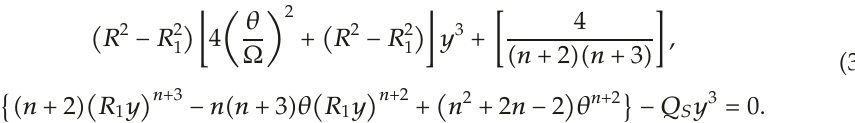
in the peripheral region δ P is taken as 0.1 (cid:5) 11 (cid:6) . The steady flow rate Q S value is taken